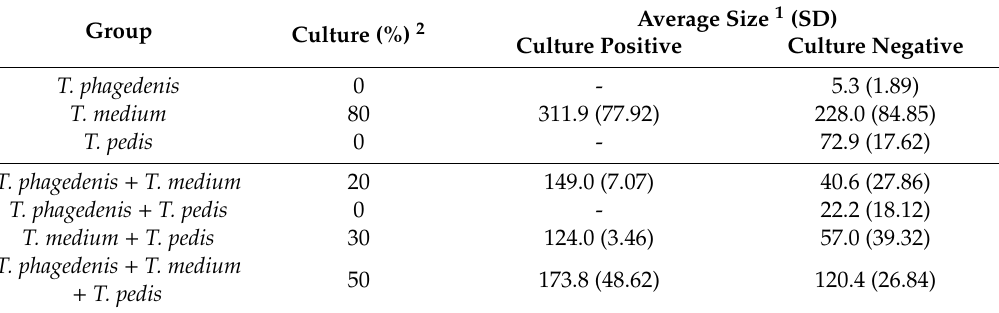
Table 1. Treponema spp. isolated in culture from abscesses of inoculated mice.